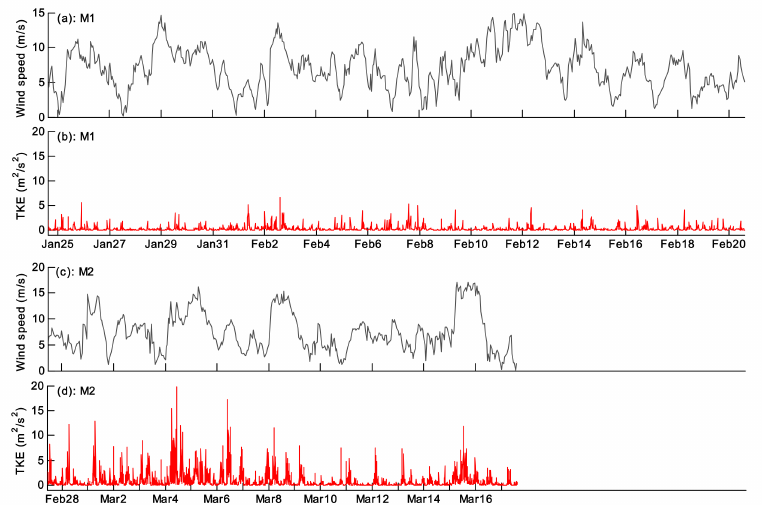
Figure 9. Comparison of wind speed and near-bottom turbulent kinetic energy (TKE) at M1 and M2 stations,